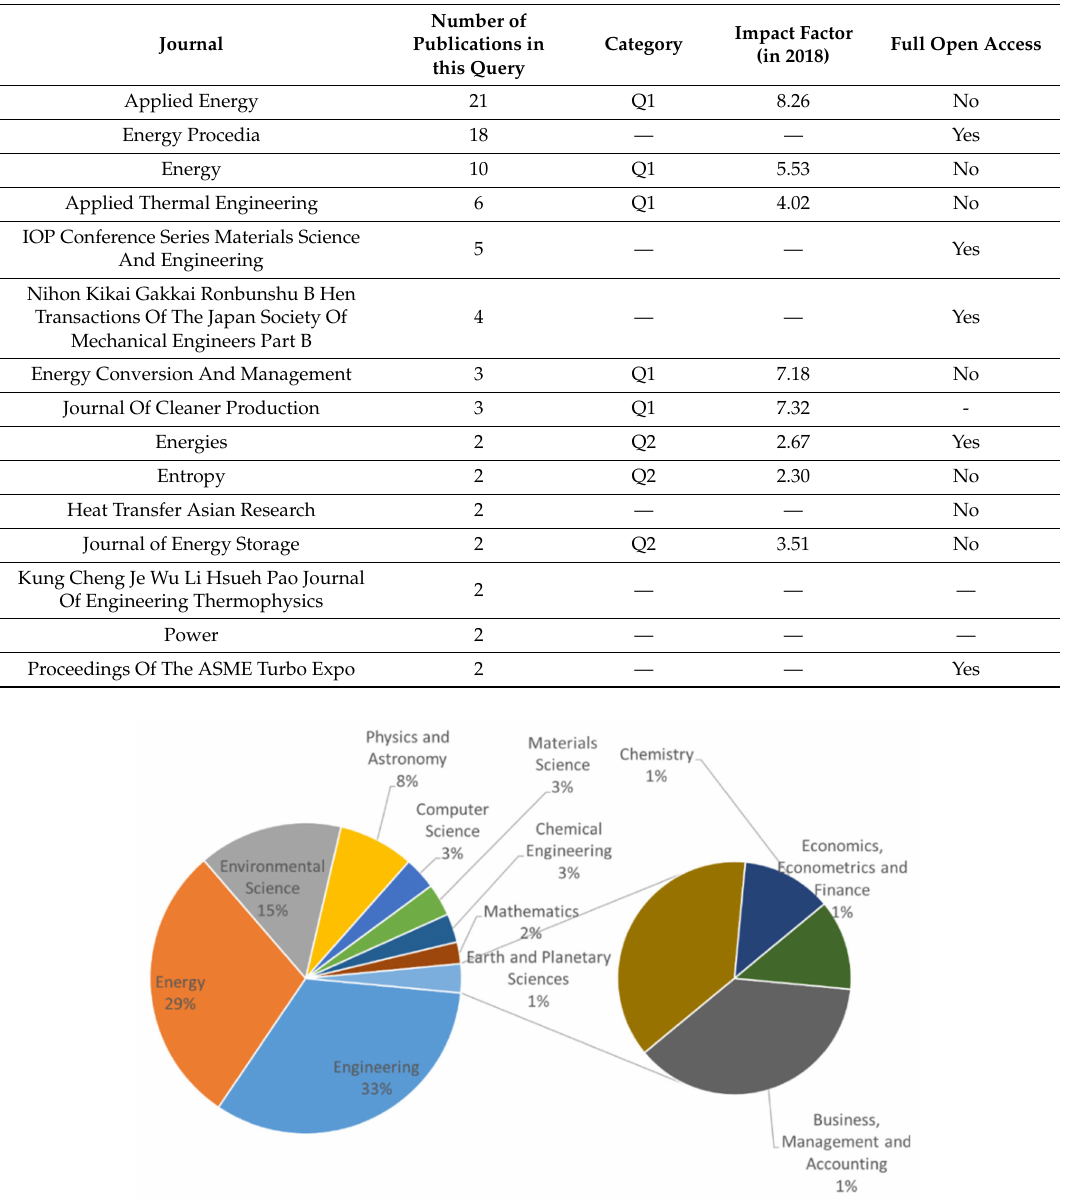
Table 1. List and characteristics of the journals with a minimum of two publications.